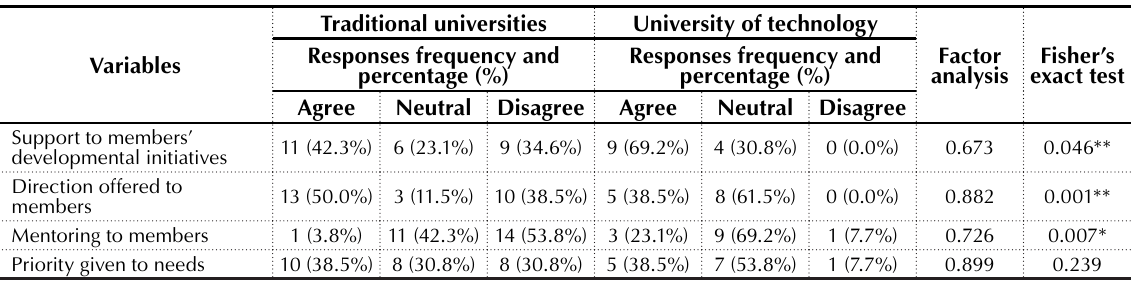
Table 3. University Community